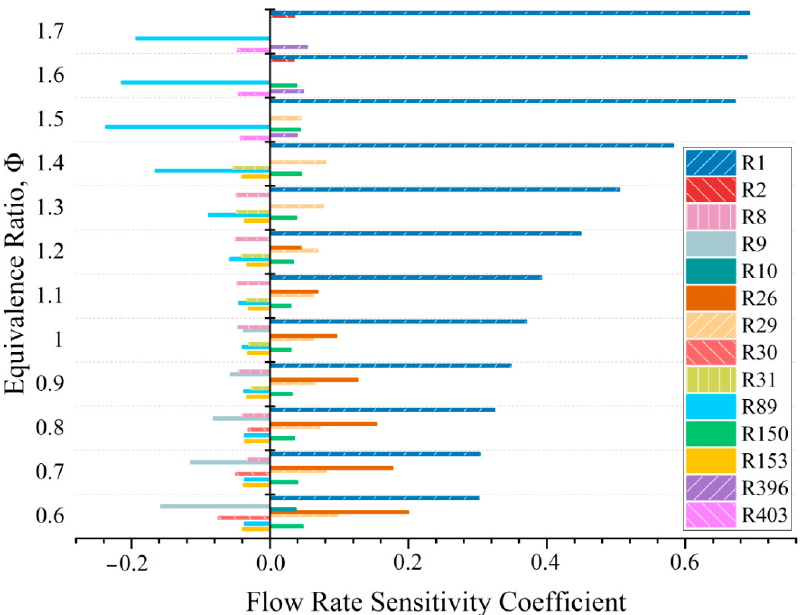
Figure 5. The flow rate sensitivity coefficients of laminar flame speed calculated with DGPA at an unburned gas temperature of 298 K and equivalent ratios of 0.6–1.7. Table 1. The chemical reactions in the legend of Figure 5.